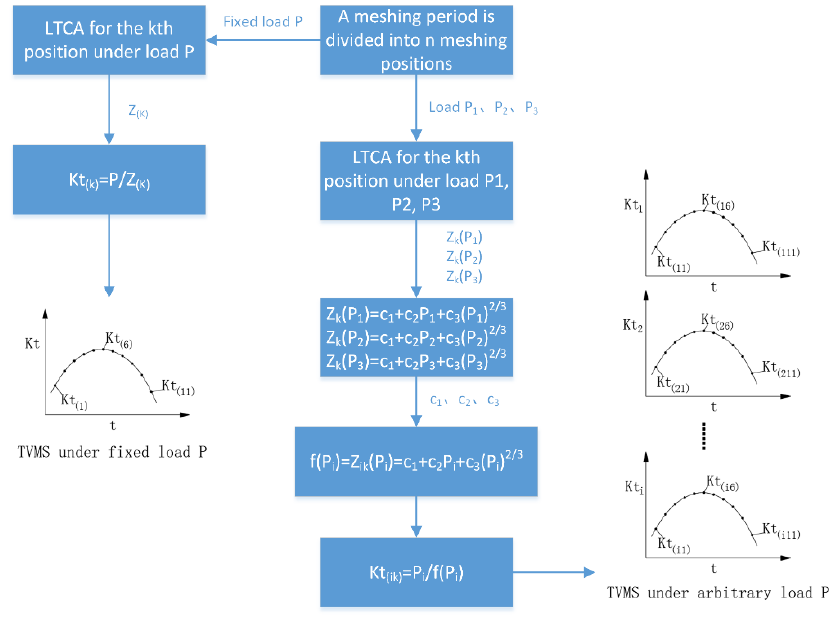
Figure 3. TVMS calculation process for the gear pair.